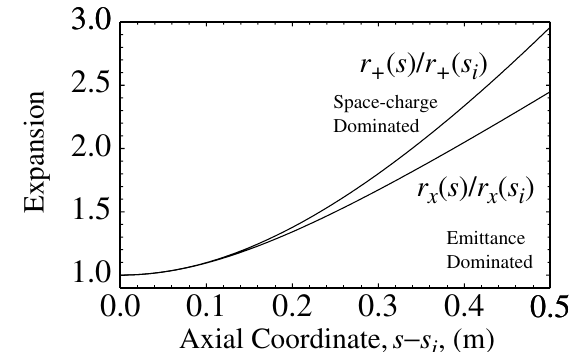
(cid:3) s (cid:4) =r (cid:3) s (cid:4) and x x i . Curves i